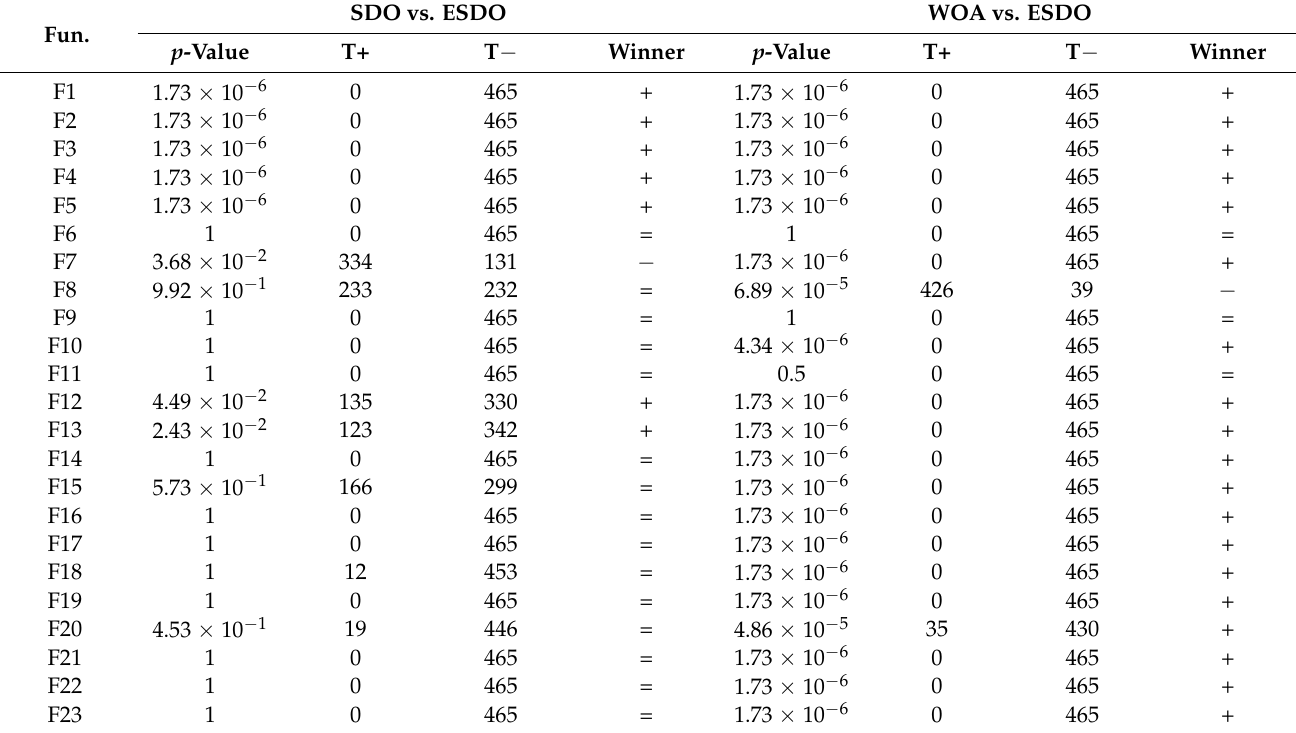
Table 5. WSRT results of ESDO for SDO and WOA.